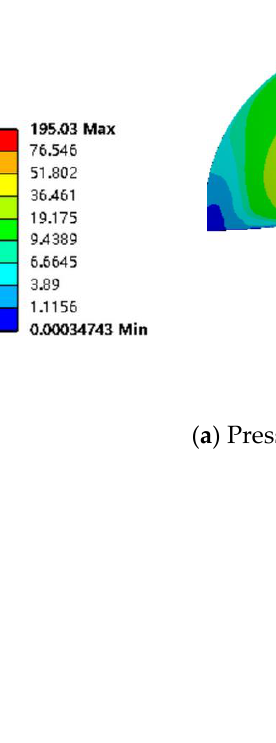
( b ) Suction surface Figure 14. Q = 10 m 3 /s Equivalent stress distribution of impeller, Unit: MPa. Figure 15 shows the equivalent force distribution of the suction surface and pressure surface of the axial-flow pump blade under the design flow condition. Under this operat-